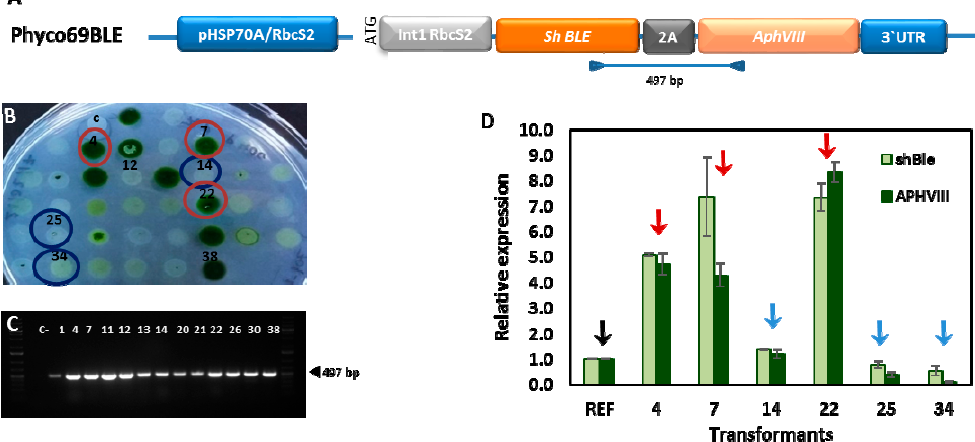
Figure 3. Relative expression of genes ShBLE and APHVIII in a series of Chlamydomonas transformants resistant to paromomycin. Chlamydomonas was transformed with the plasmid Phyco69BLE ( A ), and a selection of clones resistant to paromomycin and phleomycin ( B ) were analyzed by PCR using genomic DNA as target to test correct insertion of the BLE-2A-APHVIII cassette ( C ), and by real-time PCR ( D ) to test the relative expression level of the genes ShBLE ( ) and APHVIII ( ). Red arrows indicate the clones which show an important increase (>5 times) in the expression levels of APHVIII and ShBLE in relation with the reference transformed clone ( ↓ ), and correspond to the clones circled with a red line in panel B. Blue arrows denote the clones with a small difference in the expression of these genes in relation with the reference transformed clone and correspond to the clones circled with a blue line in panel ( B ). The expression of all genes was normalized to the ubiquitin ligase ( UBQL ) house-keeping gene and presented as fold-change relative to the transcript level of the reference transformed clone, which was chosen among those transformants which show low expression levels. Values are the average of three replicates, and bars indicate standard deviation.